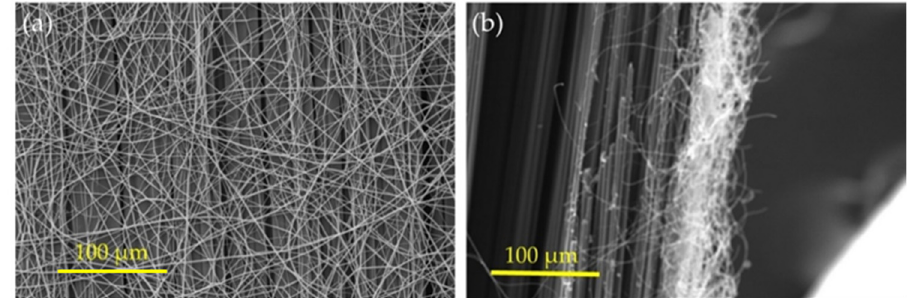
Figure 3. FE-SEM micrographs of ( a ) 0.05 g·m − 2 deposition of the functionalized PAN nanofiber layer on the surfaces of unidirectional carbon fiber ( b ) the cross-section 1 g·m − 2 deposition of functionalized PAN nanofiber layer on the surfaces of unidirectional carbon fiber.